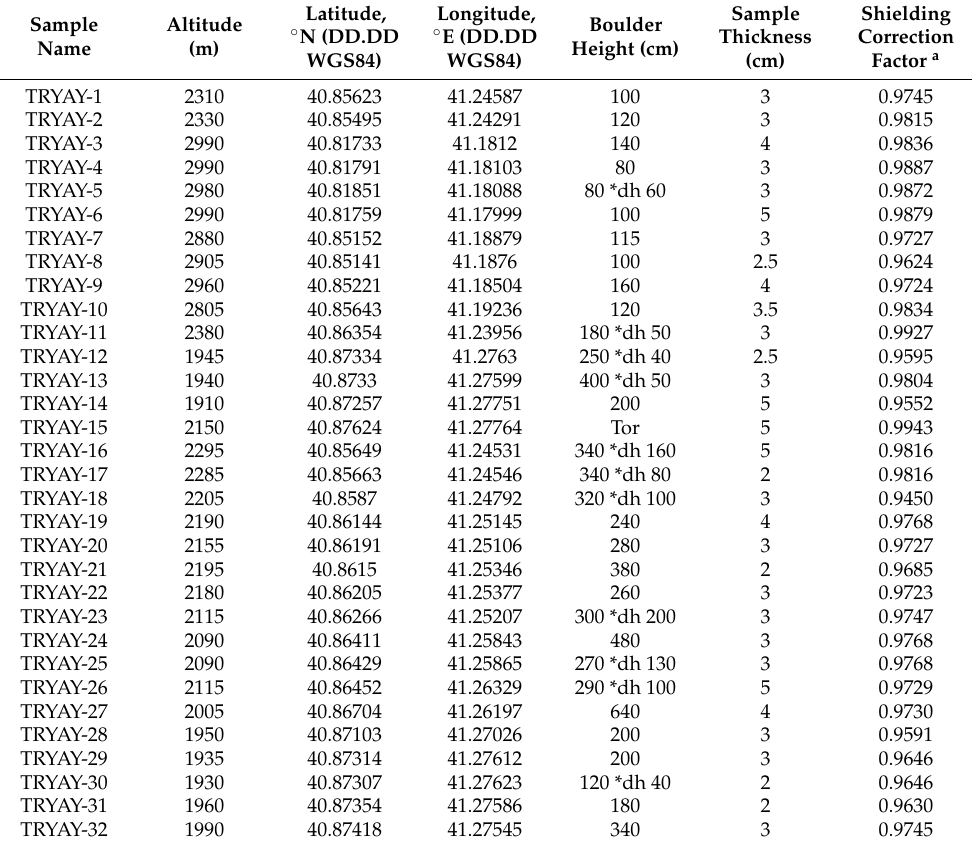
Table 1. Sample location and